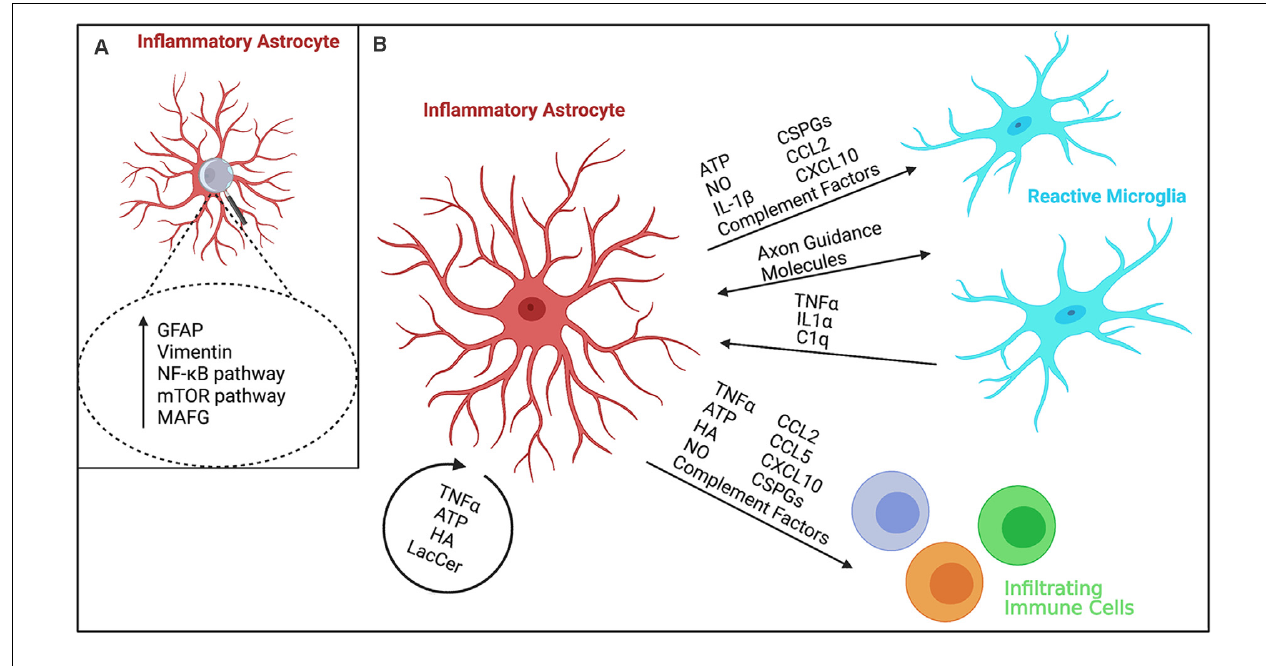
FIGURE 1 | Schematic representation of inflammatory astrocytes and their interactions with other cells during neuroinflammation. (A) Markers upregulated in inflammatory astrocytes and pathways regulating their activation. While GFAP and Vimentin are commonly upregulated in reactive astrocytes (Sofroniew, 2009; Escartin et al., 2021), inflammatory astrocytes show increased expression of the NF- κ B pathway (Zamanian et al., 2012; Lian et al., 2015) and activation of MAFG and mTOR signaling (Sofroniew, 2009; Zamanian et al., 2012; Li et al., 2015; Wheeler et al., 2020a). (B) Schematic overview of various known cytokine, chemokine, ionic, and protein interactions of inflammatory astrocytes with neighboring cells. Inflammatory astrocytes can affect microglia and infiltrating immune cells by secreting immune factors such as cytokines and chemokines (Sofroniew, 2009; Zamanian et al., 2012; Liddelow et al., 2017; Clark et al., 2019), complement proteins (Zamanian et al., 2012; Lian et al., 2016; Liddelow et al., 2017), as well as extracellular matrix molecules such as hyaluronan (HA; Kuipers et al., 2016; Nagy et al., 2019) and chondroitin sulfate proteoglycans (CSPGs; Keough et al., 2016; Stephenson et al., 2018), and cytotoxic factors, such as nitric oxide (NO), adenosine triphosphate (ATP; Orellana et al., 2011), and mitochondrial fragments (Joshi et al., 2019). These cells can, in turn, affect astrocyte reactivity as well (Colombo and Farina, 2016; Rothhammer et al., 2016; Liddelow et al., 2017; Williams et al., 2020; Clark et al., 2021). In particular, microglia have been shown to affect inflammatory astrocyte function (Liddelow et al., 2017; Yun et al., 2018; Joshi et al., 2019), while concurrently inflammatory astrocytes release many microglia-activating factors (Zamanian et al., 2012; Guedes et al., 2018) resulting in a feed-forward loop of activation. In addition, microglia-astrocyte crosstalk (Matejuk and Ransohoff, 2020) has been implicated in driving disease pathology, for example through the release of chemokines/cytokines (Itoh et al., 2017) and direct protein-protein interaction through axon guidance molecules, such as Sema4D/PlexinB2 and EphrinB3/EphB3 (Clark et al., 2021). Astrocytes can also activate themselves in an autocrine manner through the release of cytokines (Sofroniew, 2009; Zamanian et al., 2012; Escartin et al., 2021), ATP (Sofroniew, 2009; Zamanian et al., 2012), inflammatory HA (Kuipers et al., 2016; Nagy et al., 2019), and certain glycolipids such as lactosylceramide (LacCer; Mayo et al.,